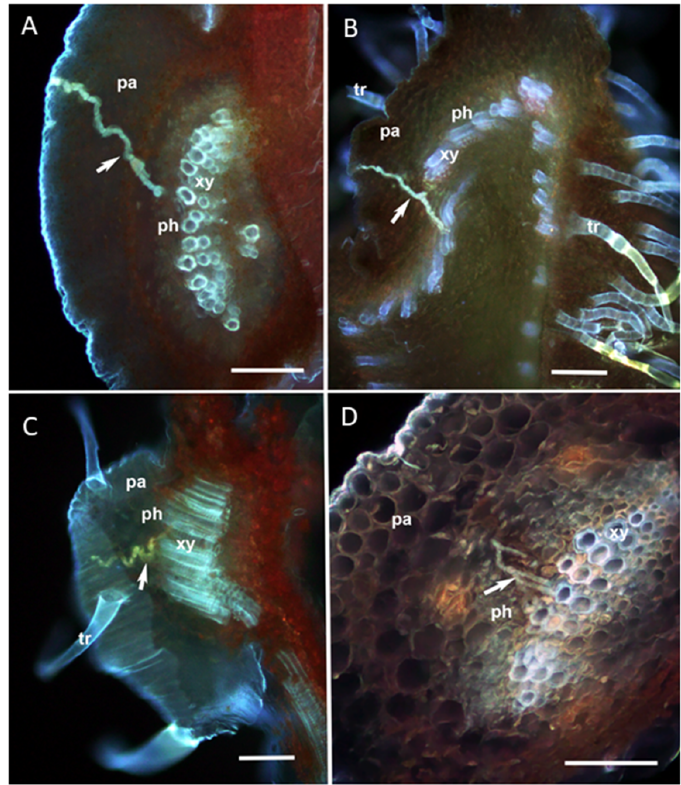
Figure 4. Fluorescence micrographs of cross section in the midribs of ( A ) Citrus macrophylla ,